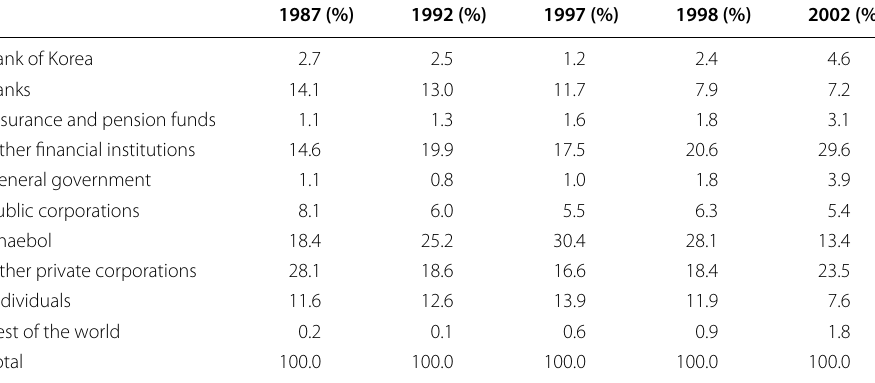
Table 6 Financial asset portfolios of the chaebol (using table Y , in